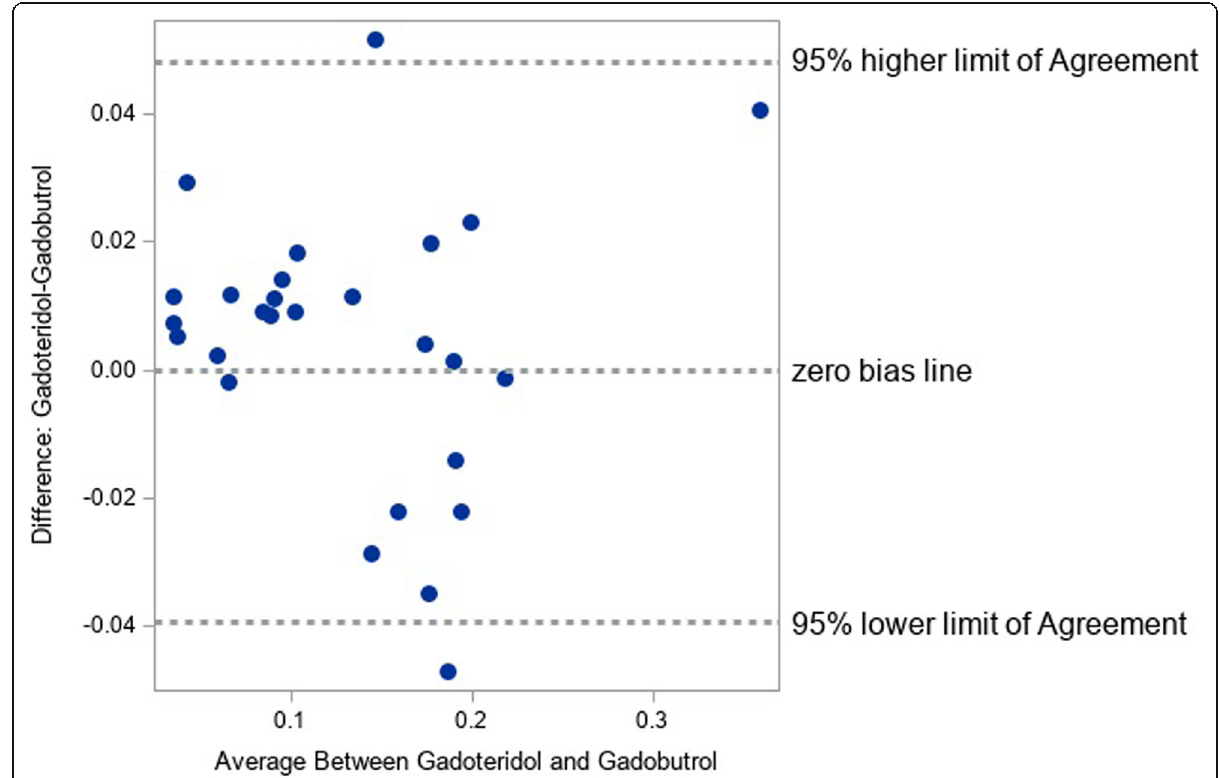
Fig. 8 Bland-Altman plot for agreement of normalised net quantitative